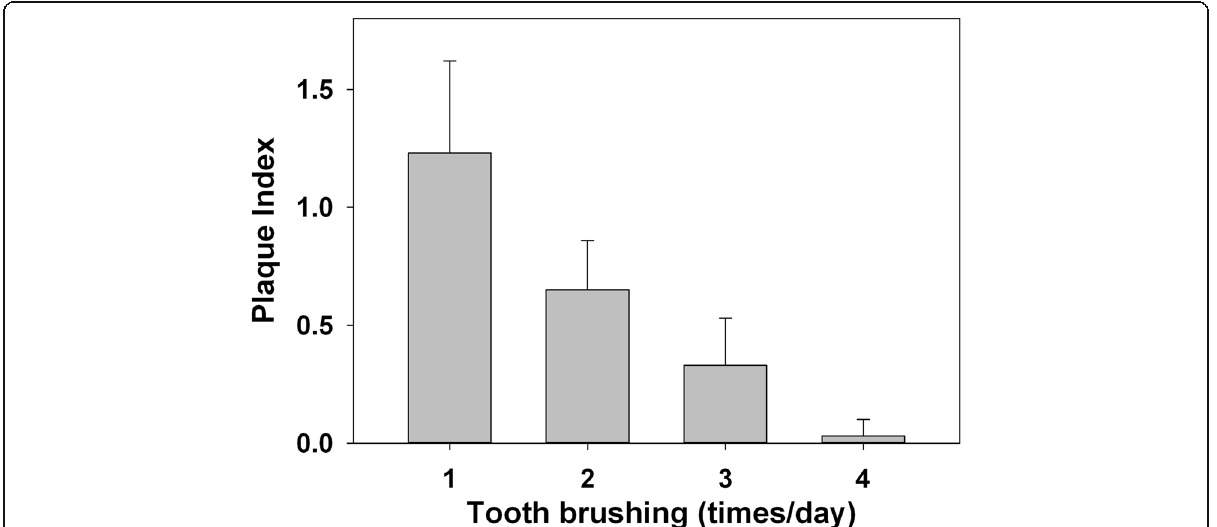
Fig. 5 Biofilm formation in patients with different daily tooth brushing frequencies. A significantly association was found between the frequency of daily tooth brushing and the amount of biofilm formation ( P < 0.001). Note the pronounced gradient showing less biofilm in patients reporting higher frequency of tooth